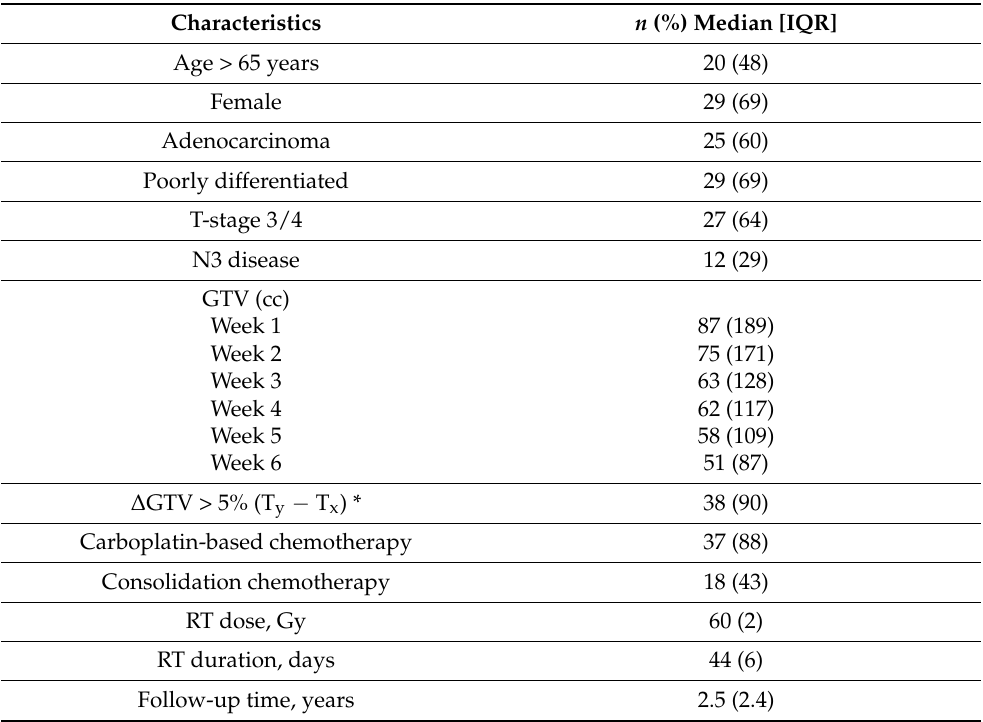
Table 1. Patient characteristics and treatment ( N =